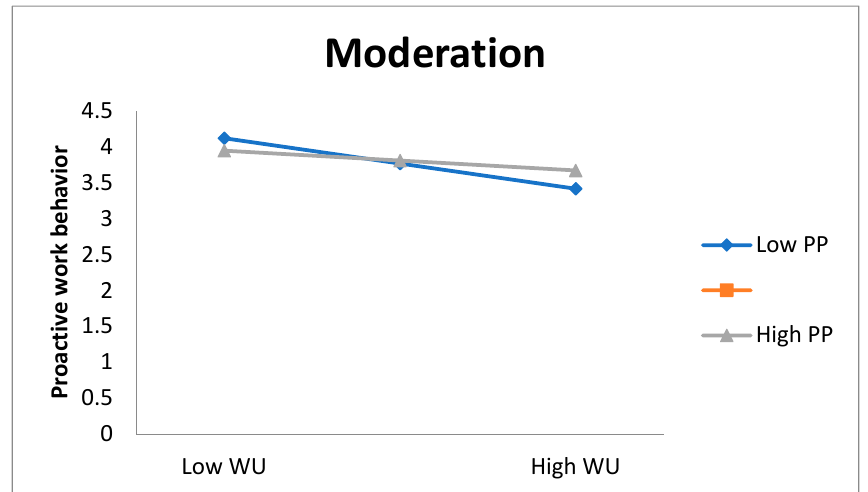
Figure 3. Moderation relationship plot. EL = entrepreneurial leadership, PP = proactive personal- ity.